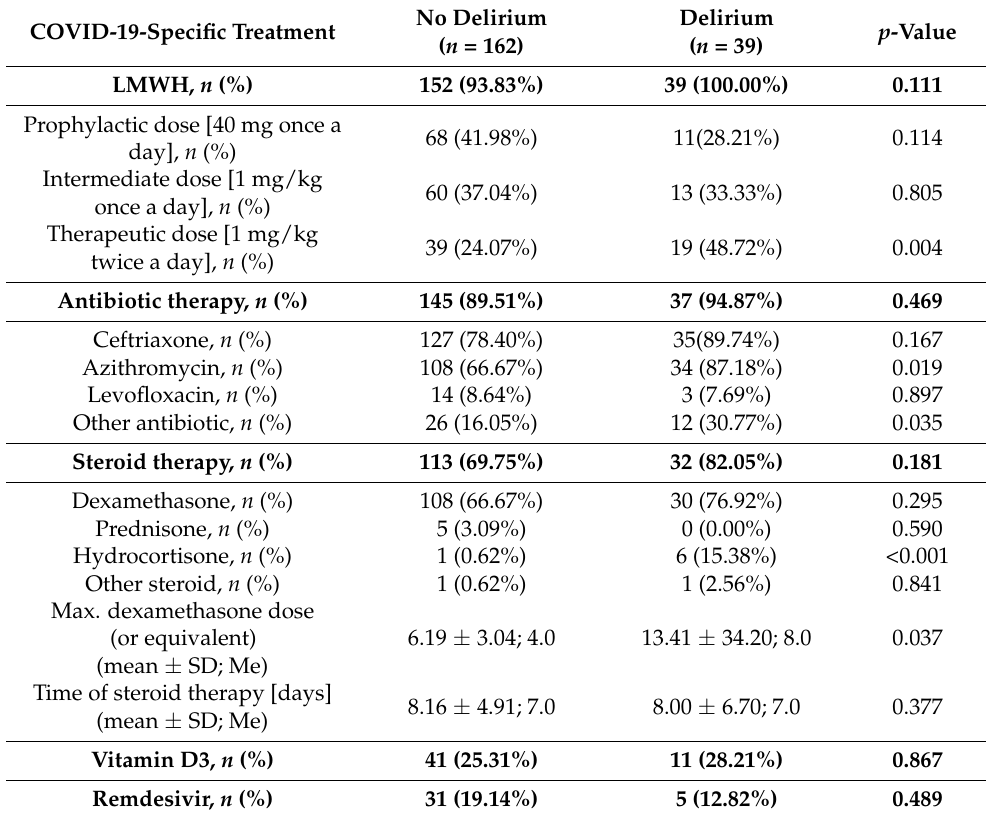
Table 6. Data regarding COVID-19-specific treatment during hospitalization.